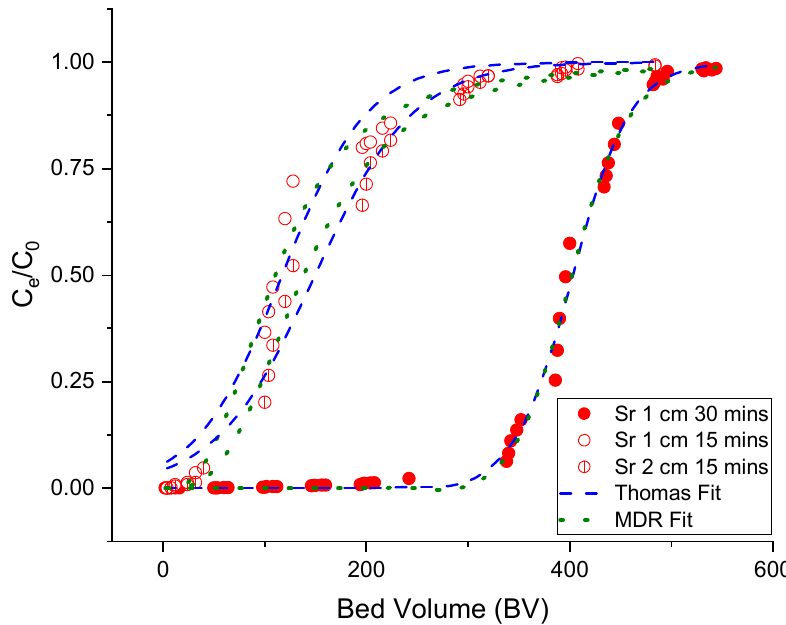
Figure 4. Static column breakthrough data for strontium contamination at 100 ppm concentration, highlighting the effect of concentration, residence time, and column scale-up, along with Thomas and Modified Dose Response (MDR) model fits.